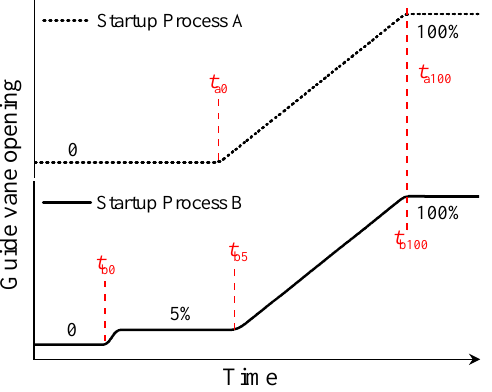
Figure 17. The time histories of the guide vane opening after the ball valve started to